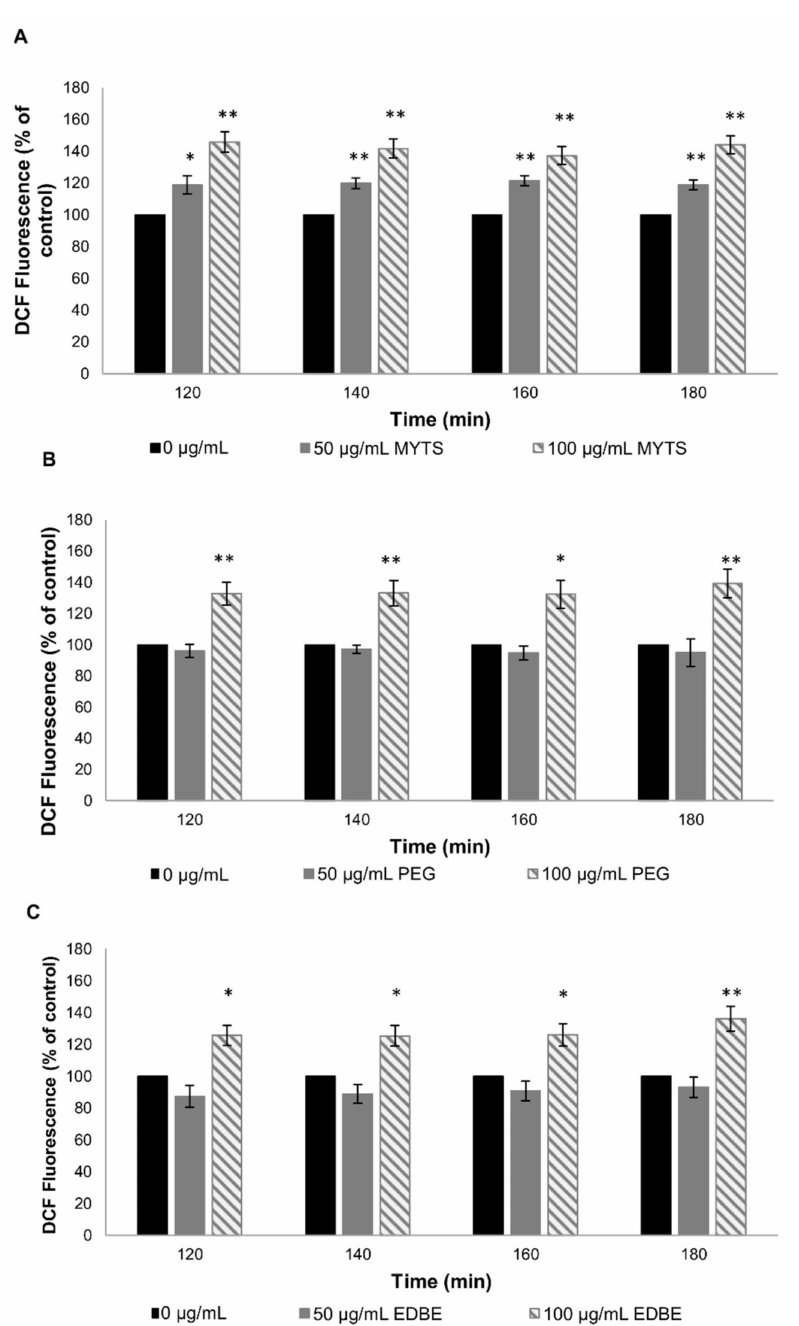
Figure 6. Effects of MYTS, MYTS-PEG and MYTS-EDBE on C. elegans ROS production. Synchronized worms ( n = 50) were treated with or without 50 and 100 µ g/mL of unconjugated MYTS ( A ), MYTS- PEG ( B ), MYTS-EDBE ( C ). NPs were diluted in water and incubated with the animals for 2 h at 20 ◦ C in agitation (70 rpm). Control worms (0 µ g/mL) were treated with water. The results are obtained from three independent experiments. Data are expressed as the mean ± standard error (SE). * p < 0.05, ** p < 0.01 vs. controls were calculated by Student’s t